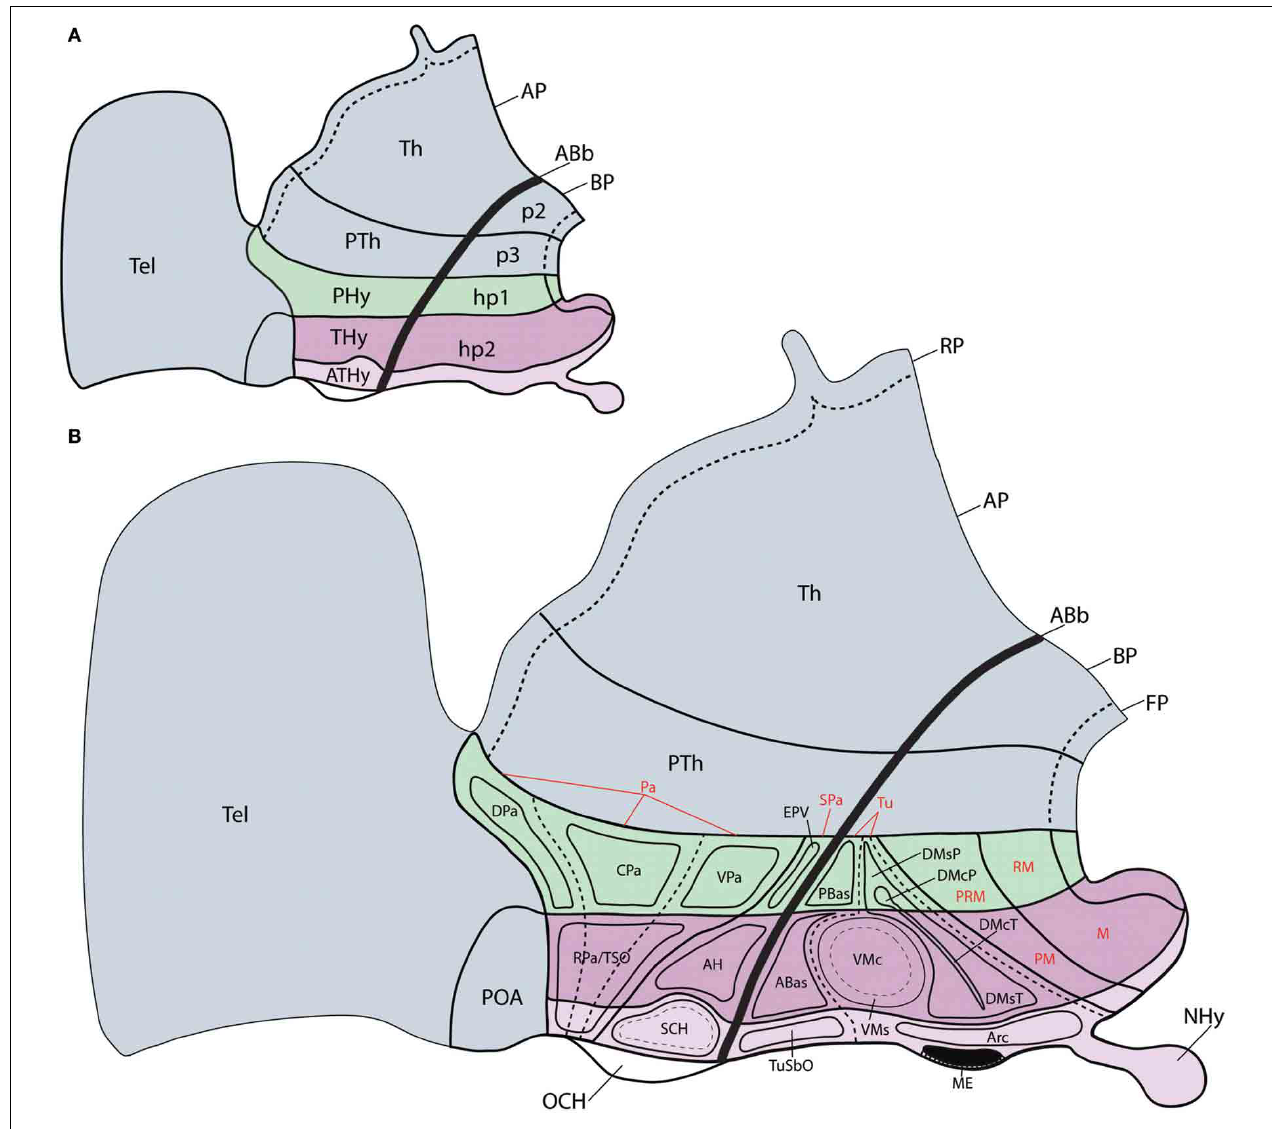
FIGURE 1 | Schemata representing the updated prosomeric model of the forebrain (excepting diencephalic p1), in which the general position, morphological organization and principal nuclear and genoarchitectonic subdivisions of the hypothalamus are detailed. (A) Schema showing the two rostral diencephalic prosomeres (p2 and p3) and the hypothalamo-telencephalic prosomeres 1 and 2 (hp1 and hp2). Note hp1 contains the peduncular hypothalamic region (PHy), whereas hp2 includes the terminal hypothalamic region (THy) and the rostralmost, median acroterminal domain (ATHy). (B) Schema of the main hypothalamic progenitor areas distributed across the dorsoventral and anteroposterior dimensions. The longitudinal alar/basal boundary (ABb) is indicated as a thick dark line. The hypothalamic area is subdivided rostrocaudally into neuromeric THy and PHy parts (pink and green, respectively). Alar territories (AP) are shown on the left, and basal ones on the right. The alar hypothalamus is